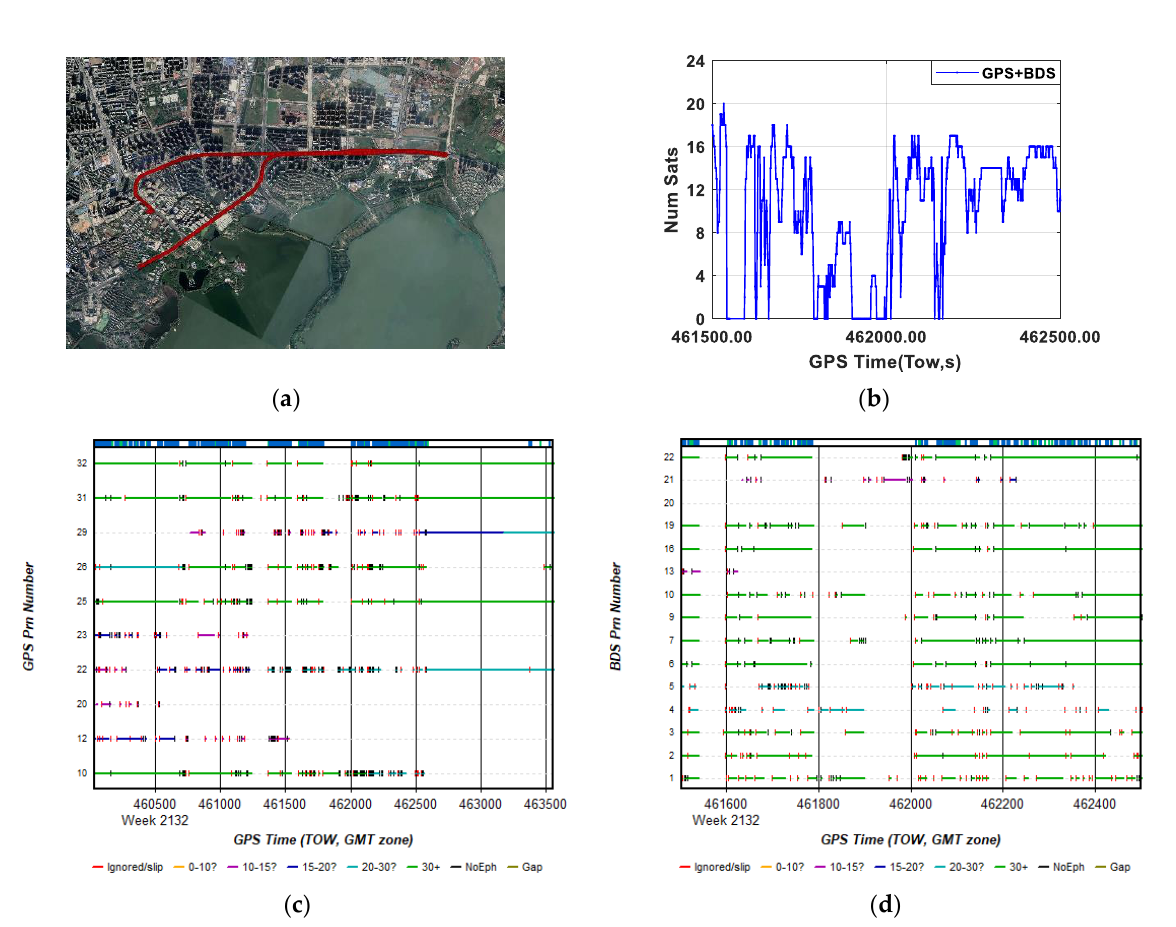
Figure 9. Second experiment in a challenged urban environment: ( a ) trajectory of vehicle; ( b ) the number of visible satellites of primary baseline; ( c ) the GPS L1 “Satellite Lock—Cycle Slips” plot from IE; ( d ) the BDS B1 “Satellite Lock—Cycle Slips” plot from IE.